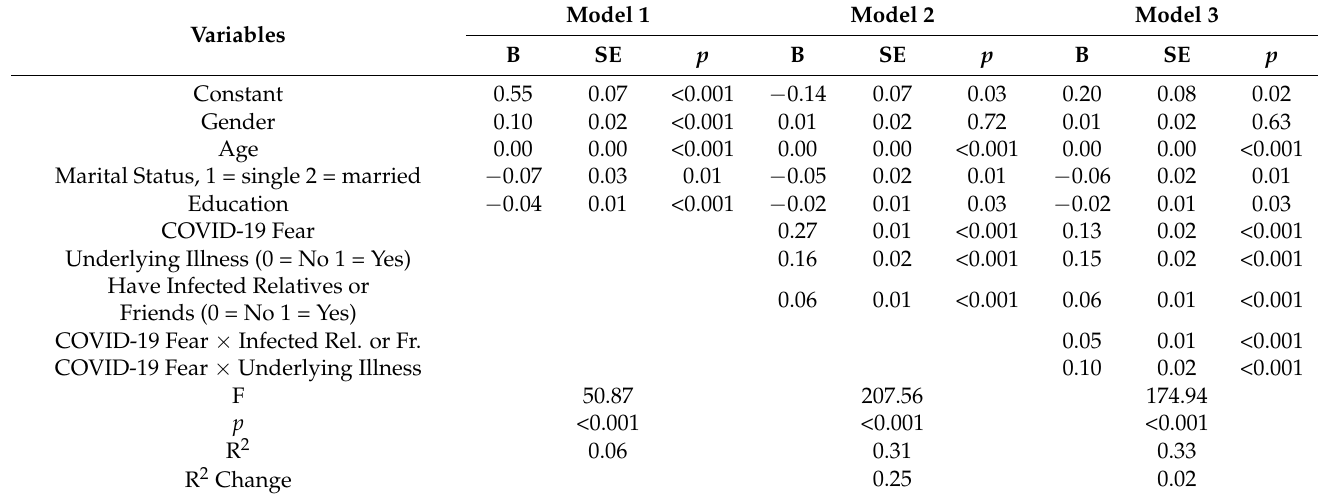
Table 4. Main and interaction effects on anxiety.